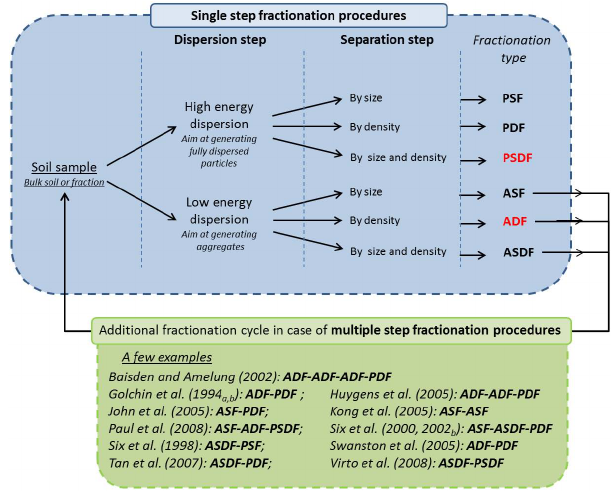
Fig. 1. Flow chart to illustrate methodological differences between soil fractionation procedures. PDF = Particle density fractionation; PSF = Particle size fractionation; ADF = Aggregate density frac- tionation; ASF = Aggregate size fractionation; PSDF = Particle size density fractionation and ASDF = Aggregate size density fractiona- tion. ADF and PSDF are highlighted in red because they were cho- sen for this